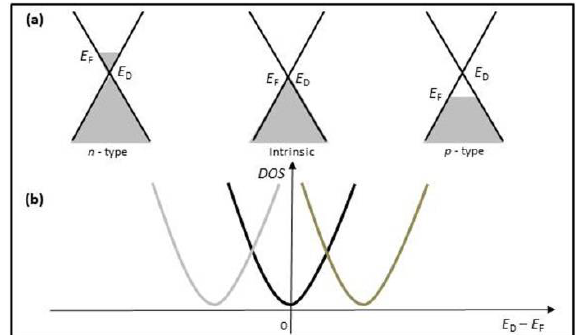
Figure 7. ( a ) Energy band diagrams of graphene: pristine graphene ( middle ), n -type graphene ( left ), and p -type graphene ( right ). ( b ) Graphene resistance as a function of gate voltage. E F and E D indicate Fermi level and Dirac point, respectively.